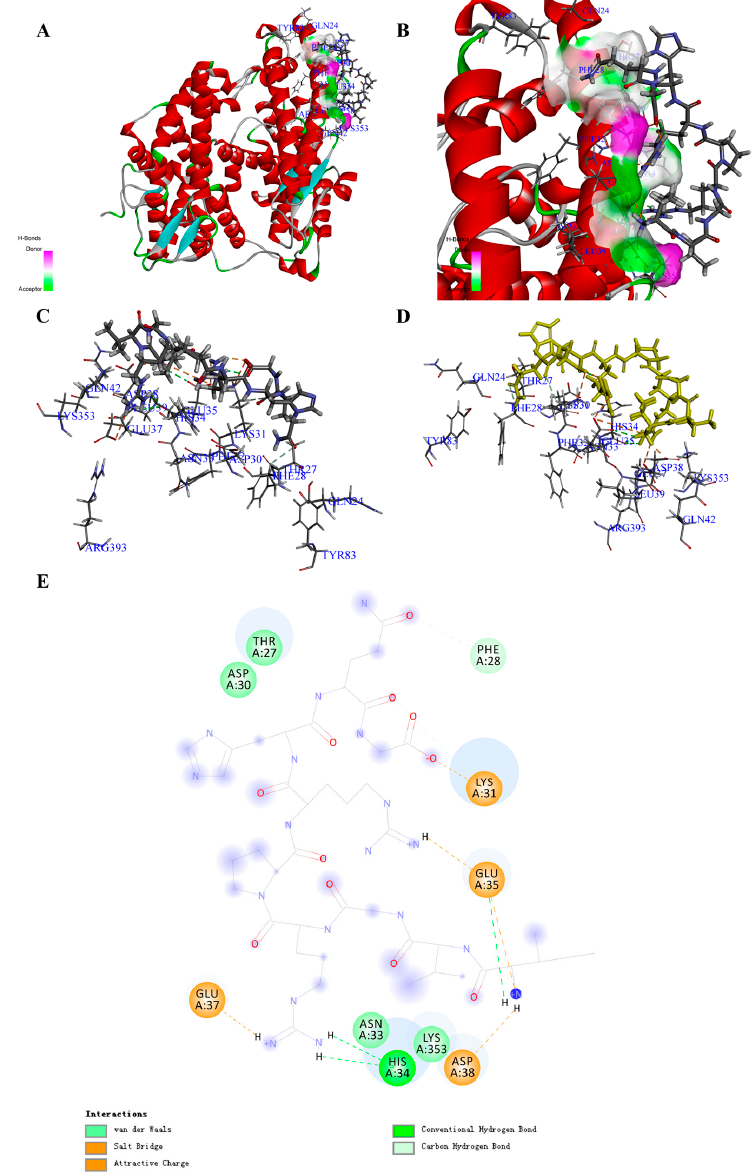
Figure 1. Structure of the COVID-19 virus spike protein receptor binding domain angiotensin- converting enzyme 2 (ACE2) complex containing potential inhibitory peptide (PA1) and its binding modes. ( A ) Three-dimensional (3D) structure of the ACE2 complex containing PA1. For clarity, the interface receptor amino acids residues are shown in thin stick style, and PA1 is shown in thick stick style. ACE2 is downloaded from PDB (No. 6M0J) and generated in DS software with deletion of the ligands. The different colors represent the different secondary structure: red is α -helix, blue is β -fold, green is β -turn, white is random coil. PA1 is the peptide, Ile-Val-Gly-Arg-Pro-Arg-His- Gln-Gly, with the highest total interaction energy to ACE2. ( B ) Enlarged view of the interface in the ACE2 complex containing PA1. ( C , D ) Binding site between PA1 and ACE2 and the main inter- action residues. Dashed line with a different color represents the non-covalent interaction between PA1 and ACE2. ( E ) 2D representation of interactions between the PA1 and amino acid residues of ACE2.